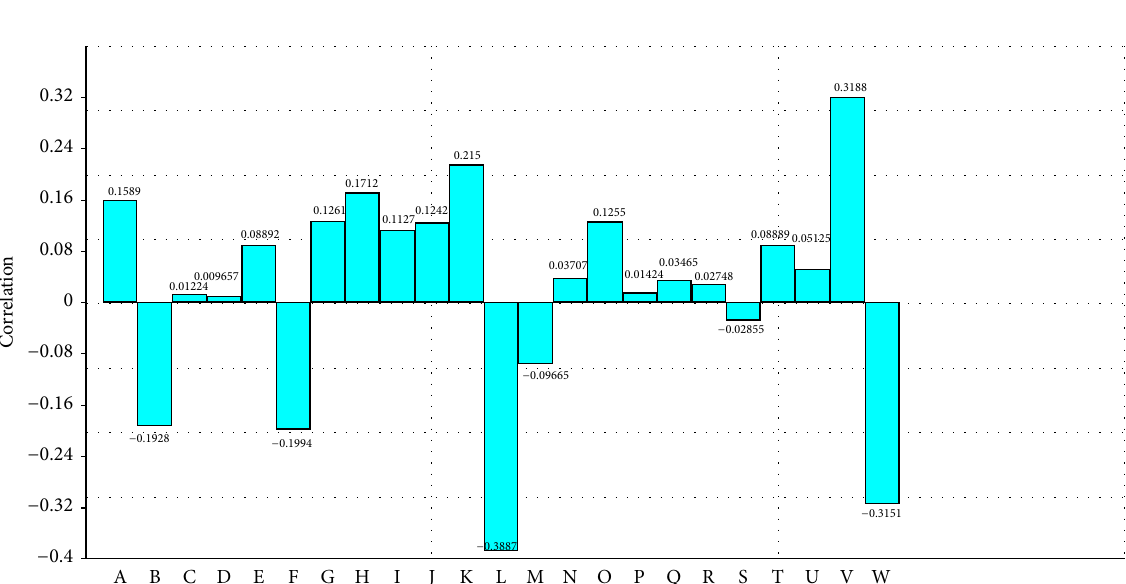
Figure 3: PCA loadings of PC 2 and its correlation with various morphometric parameters.